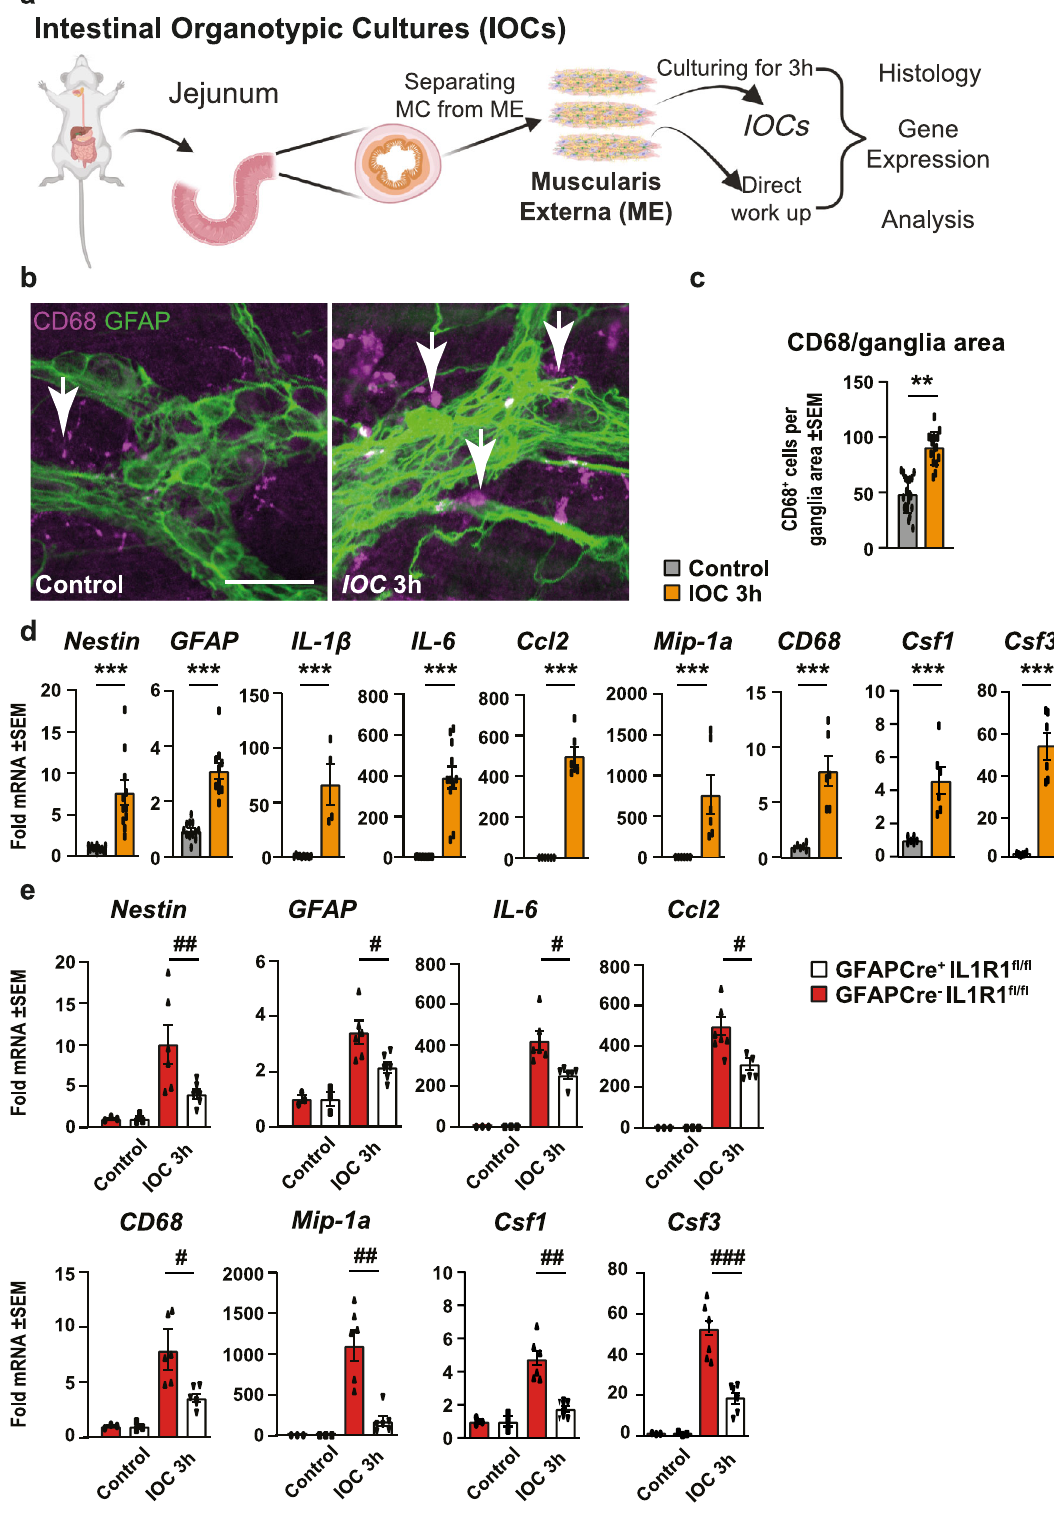
RiboTag mice con fi rmed that IL1R1-signaling is part of post- operative EGC reactivity. Around 2/3 of upregulated genes overlap between IL-1 β -stimulated EGCs in vitro and the reactive EGC phenotype induced by IM in vivo. We conclude that an IL- 1-induced EGC reactivity is a major trigger of surgery-induced enteric